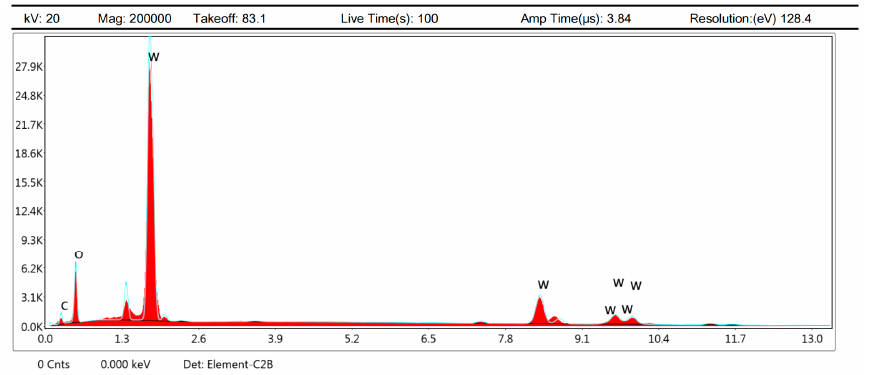
Figure 11. The EDS pattern of spots.